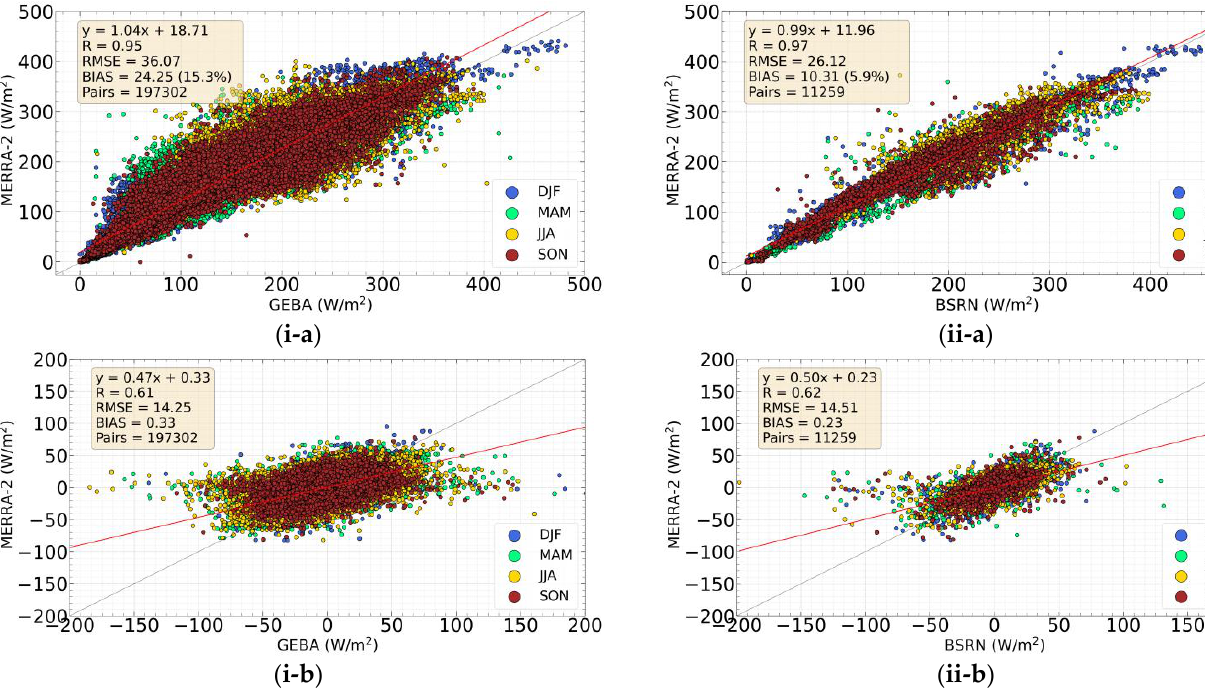
Figure 3. Scatterplot comparison between MERRA-2 Reanalysis and GEBA ( i-a ), and BSRN ( ii-a ) SSR fluxes and between MERRA-2 and GEBA ( i-b ) and BSRN ( ii-b ) deseasonalized SSR anomalies. The linear regression fit, and the associated statistical metrics, namely the equation of the applied linear fitting, the correlation coefficient (R), the root-mean squared error (RMSE), the bias and the total number of matched data pairs, are also shown. The comparison is shown separately for each season (December – February, March – May, June – August and September – November) in different colors (the respective main statistical parameters are given in Table 1).